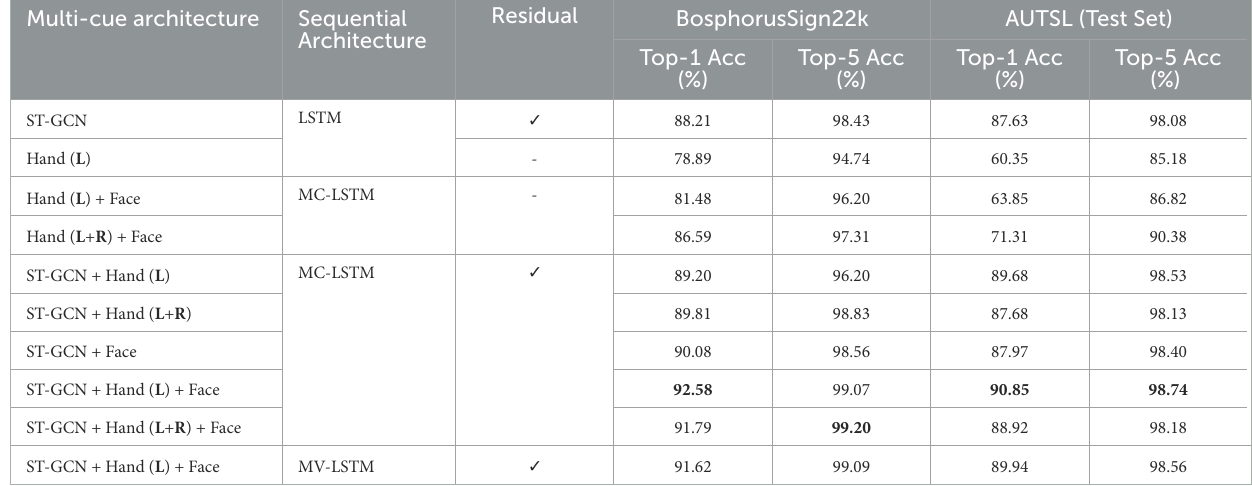
TABLE 2 Classification results for multi-cue temporal modeling with MC-LSTM using both manual (ST-GCN and Hand-DeepHand) and non-manual (Face-DAN) representations. Multi-cue